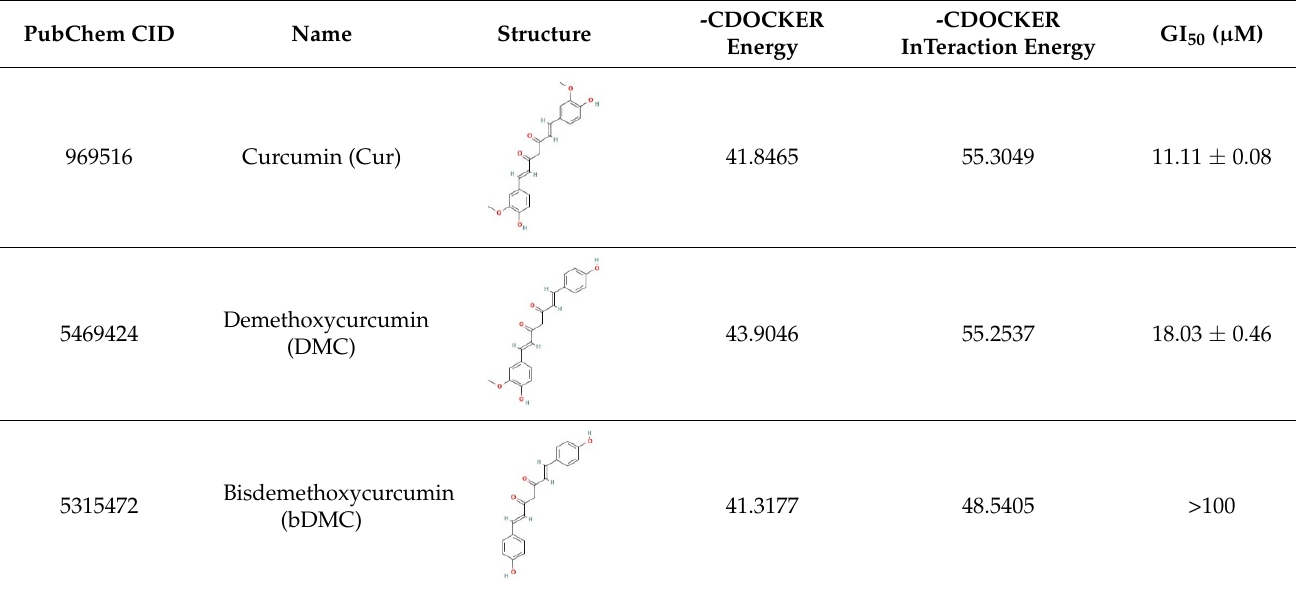
Table 1. The screening of curcuminoids (i.e., curcumin, DMC, and bDMC) by D.S. 4.5 and values of GI 50.